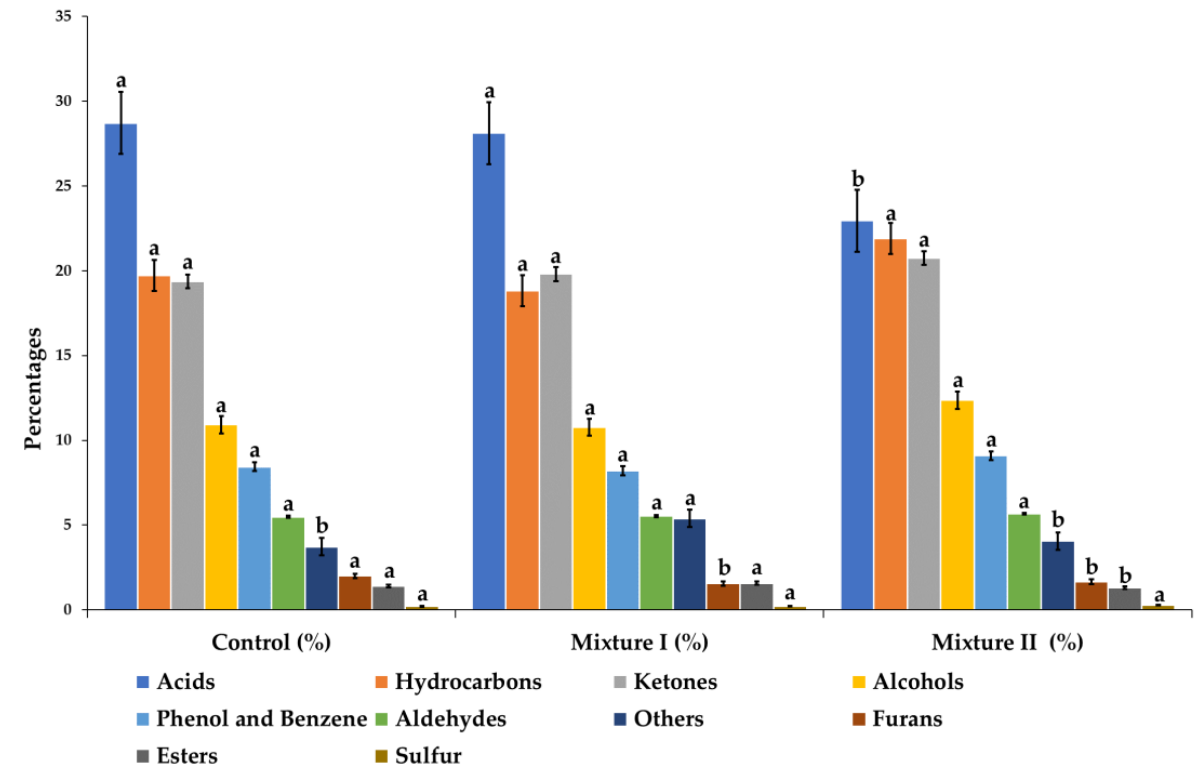
Figure 1. Chemical families of volatile compounds (percentages respect to total chromatographic area) according to the three treatments (Control: 100% NaCl; Salt mixture I: 30% NaCl and 70% KCl; salt mixture II: 30% NaCl, 50% KCl, 15% CaCl 2 , and 5% Mg 2 ). a,b Mean values ± standard error (corresponding to the same parameter) followed by a different letter differ significantly ( p < 0.05; Duncan’s test).